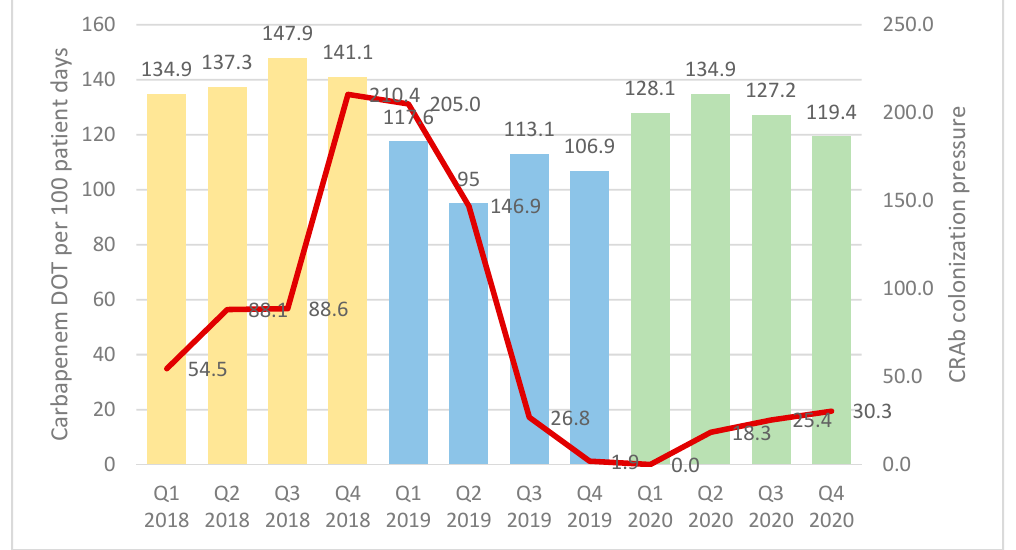
Figure 6. Carbapenem-resistant Acinetobacter baumannii colonizing pressure and carbapenem con- sumption by quarter from 2018 until 2020. DOT, Days of therapy; Q, quarter.